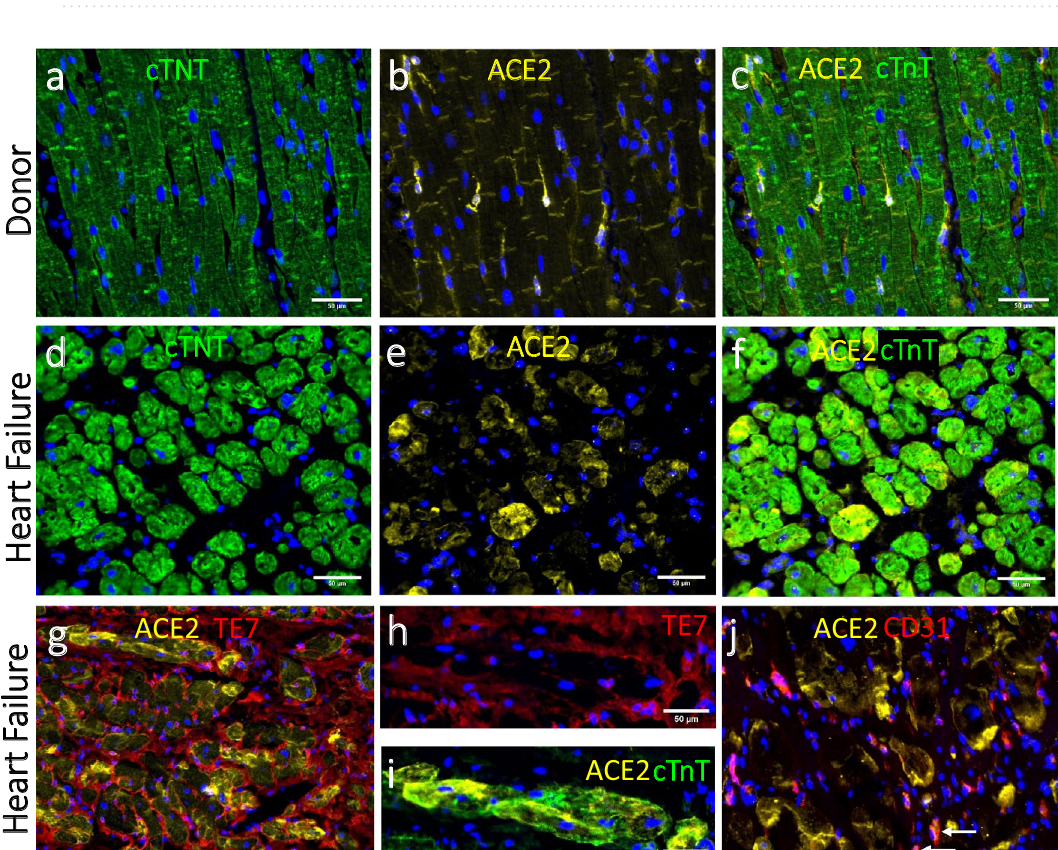
Figure 4. Protein expression of ACE2 in different cell phenotypes. (a-c) Representative images of IHC staining of the myocardium from an organ donor showing ACE2 expressing cells between cTnT + cardiomyocytes. ACE2 staining did not overlap with the expression of cTnT. (d-f) cTnT + /ACE2 + cells were identified in the myocardium from three individuals with terminal heart failure, showing ACE2 expression in cardiomyocytes. (g) In the HF group, most of the ACE2 + cells were cardiomyocytes. (h, i) Enlargement of ACE2 + / cTnT + cardiomyocytes surrounded by the Te7 + fibroblasts. (j) For the most part, ACE2 staining did not overlap with the CD31 endothelial staining in either of the groups. ACE2 + /CD31 + cells could be found (arrows), (see Suppl. Figure 3 for more